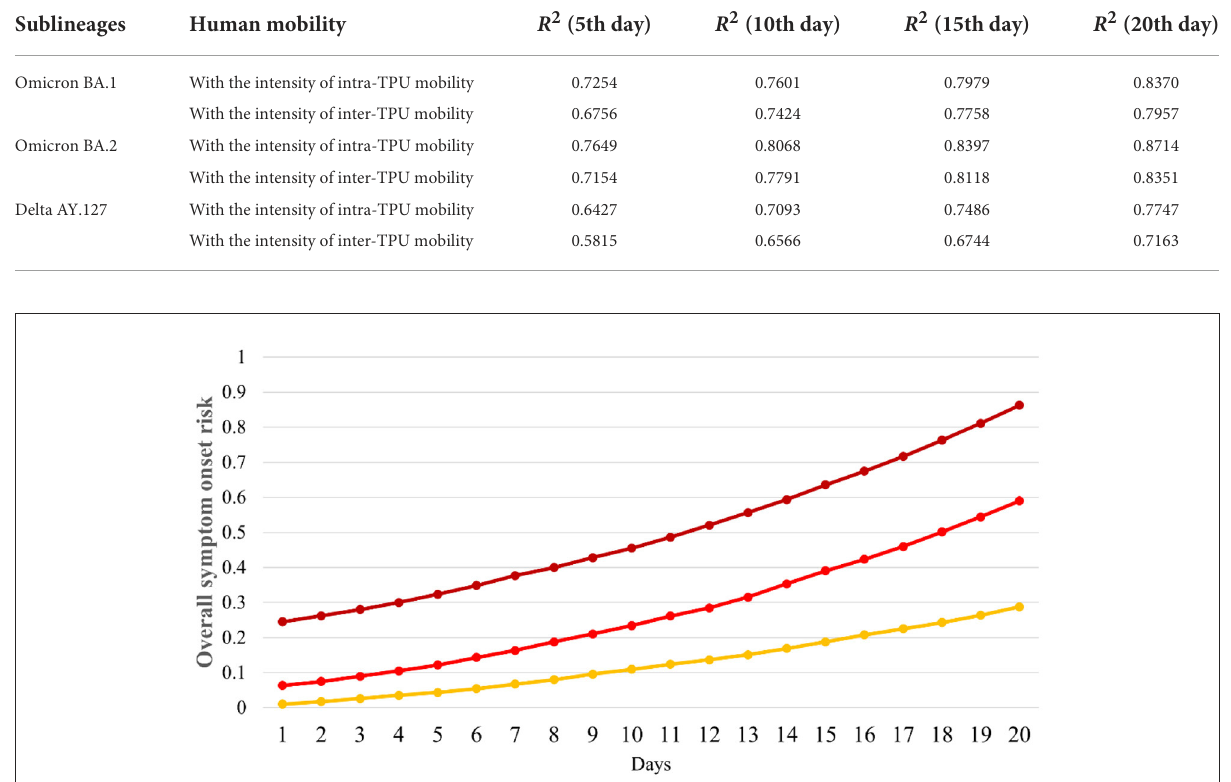
at high onset risk had an average of 83.21% lower symptom onset